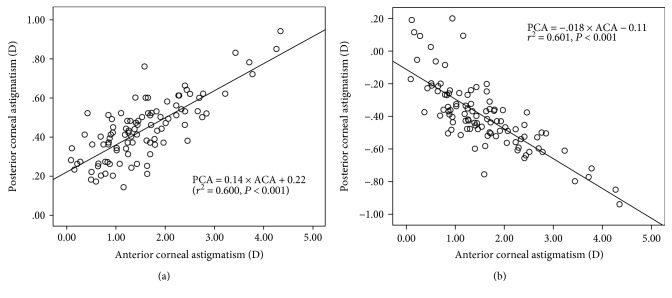
(a) Correlation between the magnitude of anterior corneal astigmatism and posterior corneal astigmatism across the whole sample. (b) Correlation between the meridional polar value AKP of anterior corneal astigmatism and posterior corneal astigmatism across the whole sample. The solid black line represents linear regression.